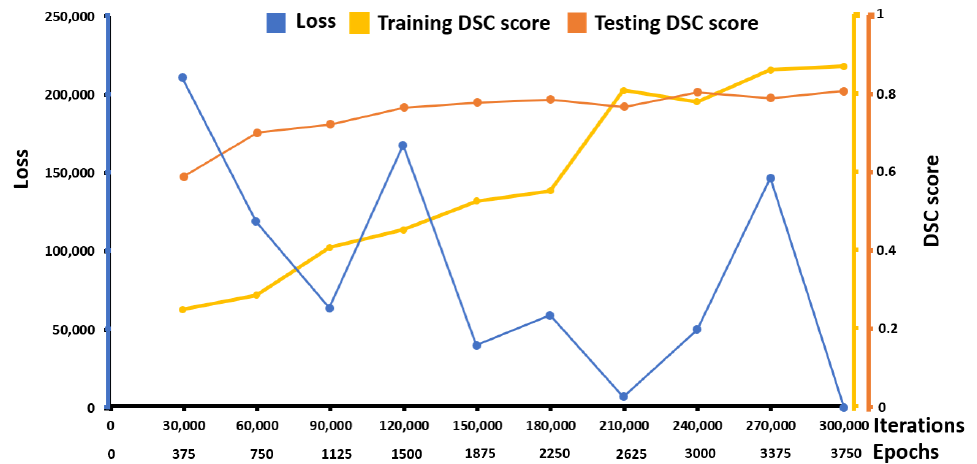
Figure 6. The results of the training loss, the training DSC scores, and the testing DSC scores through iterations/epochs represented in blue and orange,